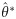
Results from outbreak simulations with the conditional subsample transmission algorithm.Average run time in seconds for each tested grid cell size up to and including the outbreak stages 10 and 10000 (* indicates estimated optimal grid cell size θ^*). The 5th and 95th percentiles are indicated by the ranges (main panels). Each combination of landscape and grid configuration using the CS algorithm, as well as simulations with the pairwise algorithm for comparison was simulated with 500 replicates. The landscapes were (panels A-F): random uniform, random moderate clustering, random high clustering, USA, Sweden, UK. The regular grid construction method was used for the uniform random landscape and the adaptive grid construction method was used for the other landscapes. The black line indicates a unitless relative expected efficacy of the different grid sizes as indicated by the grid optimum estimation method.